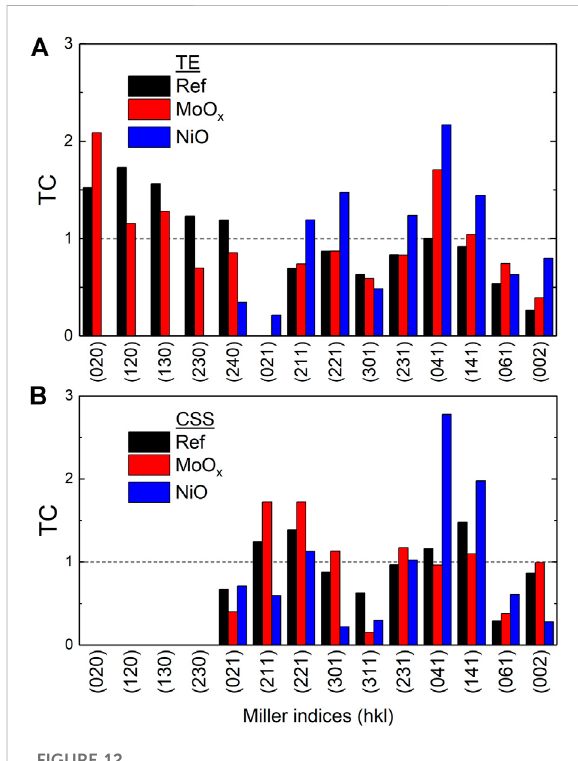
FIGURE 12 Texturecoef fi cientanalysisfromXRDpatternsofSb 2 Se 3 fi lms deposited via TE (A) andCSS (B) withdifferentholetransport layers in substrate con fi guration. A diffraction peak with a relatively large TC value ( > 1) indicates a preferred orientation of the grain along this